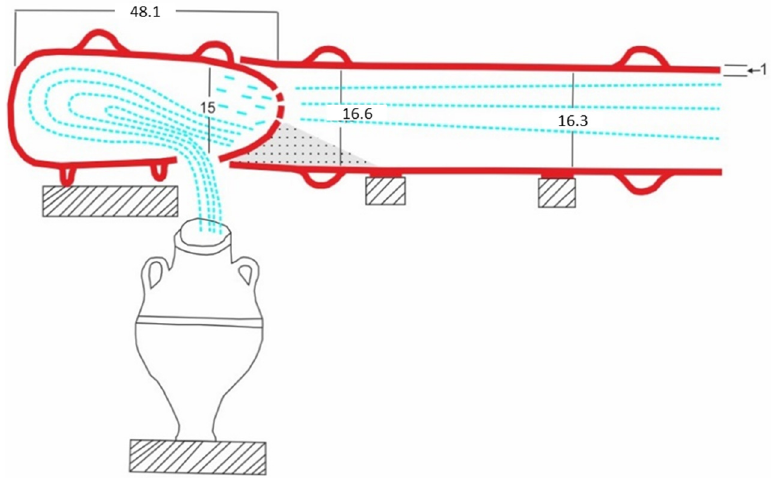
Figure 2. Minoan water ceramic filter (units are in cm) (Angelakis et al., 2020).